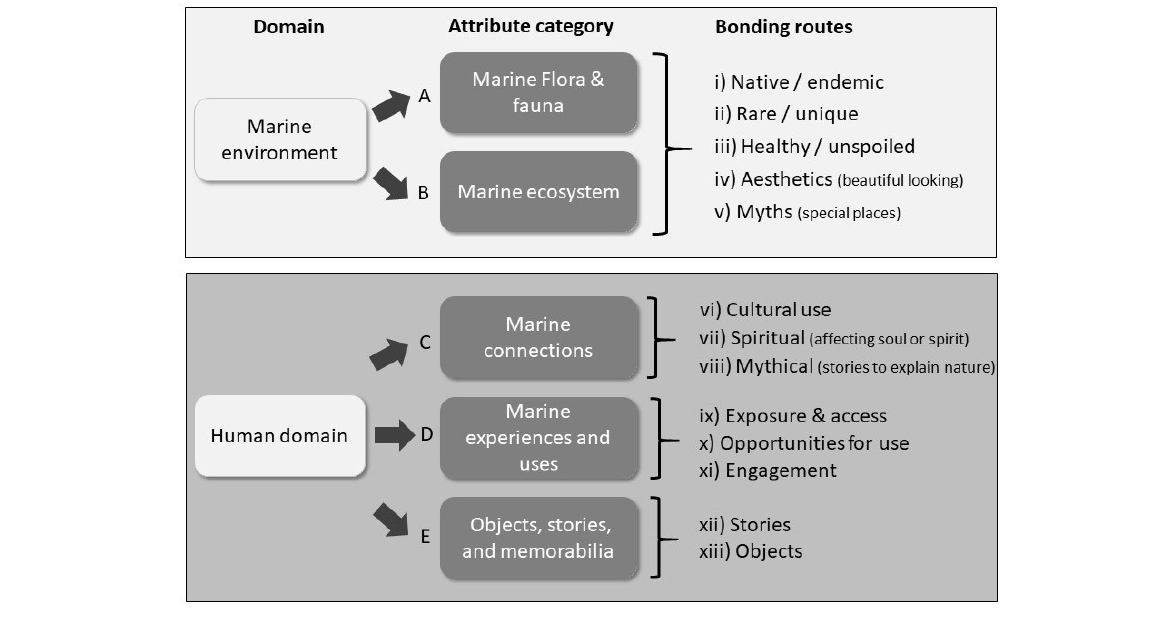
Fig. 1 . Conceptual links between domain, five attribute categories, and different processes that are (mostly) positively linked to well-being and expected to mediate greater SoP in the marine